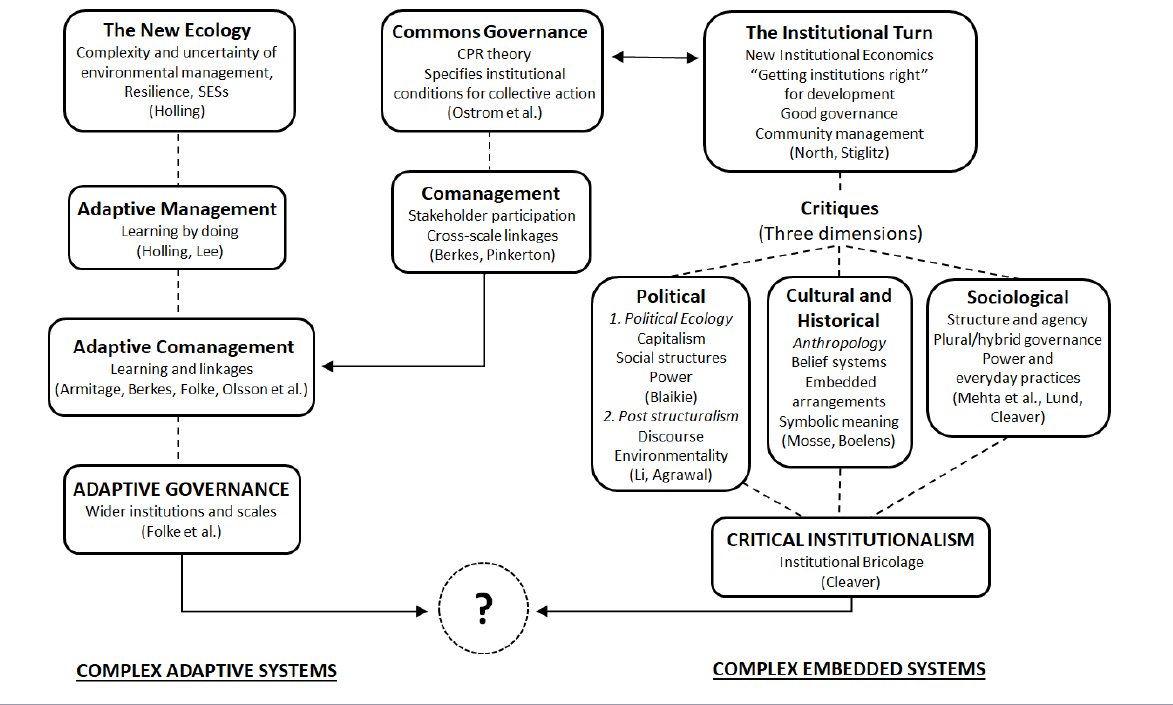
Fig. 1 . The evolution of adaptive governance and critical